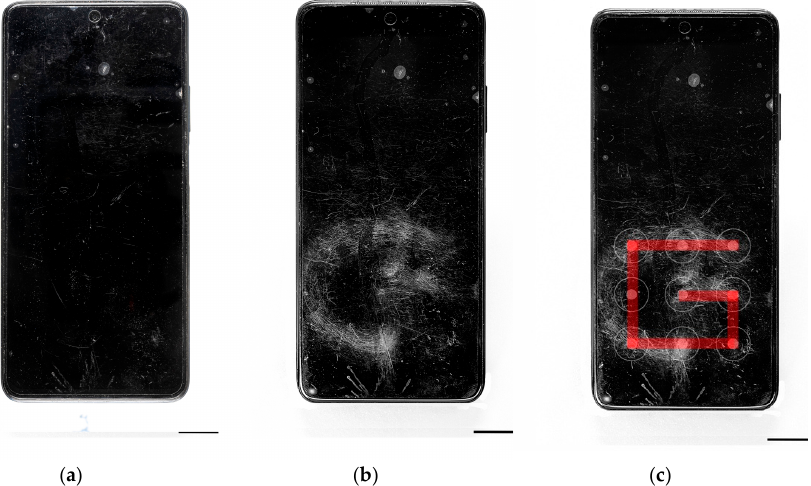
Figure 8. Images from a mobile phone photographed ( a ) with a conventional camera and illuminated with white visible light; ( b ) captured by Invespector camera and illuminated with IR radiation 950 nm; and ( c ) the pattern movement recovered to unlock the smartphone